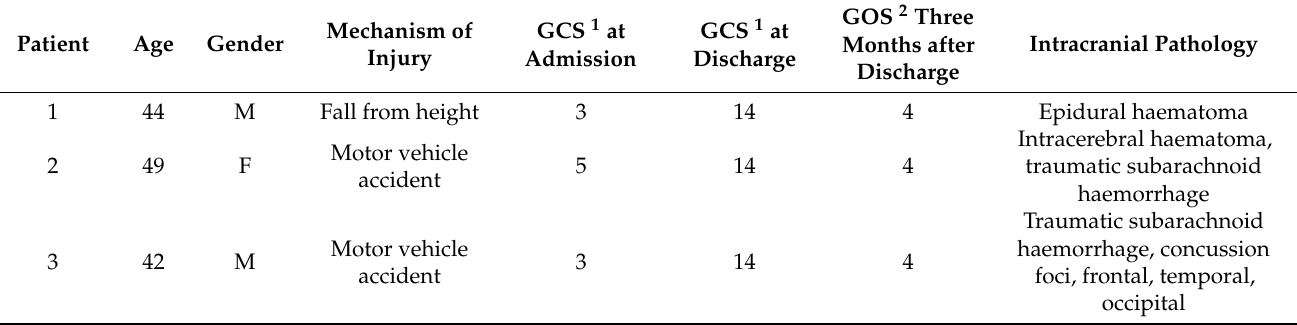
Table 1. Description of severe traumatic brain injury patients included in the